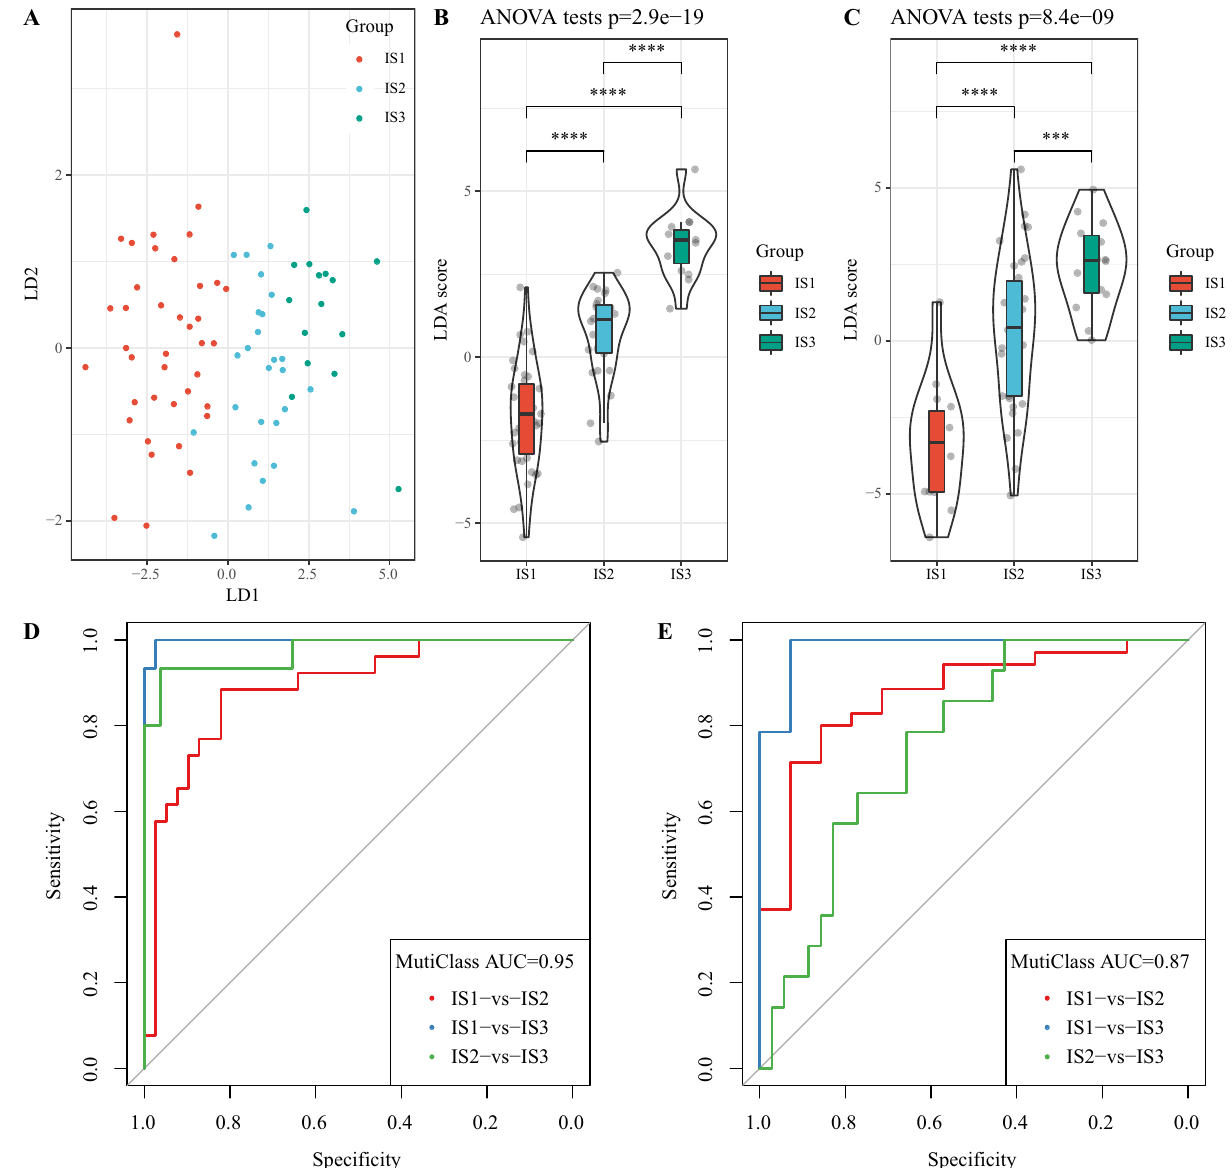
Figure 5. The LDA score can be used to measure the different immune characteristics of patients. ( A ) Relationship between the first 2 features of LDA score and ISs. ( B ) LDA score difference of different IS samples in TCGA data set. ( C ) LDA score differences of three ISs in GSE22138 data set. ( D ) ROC curve of LDA score in TCGA data set. ( E ) ROC curve of LDA score in GSE22138 data set. *** P < 0.001; **** P <